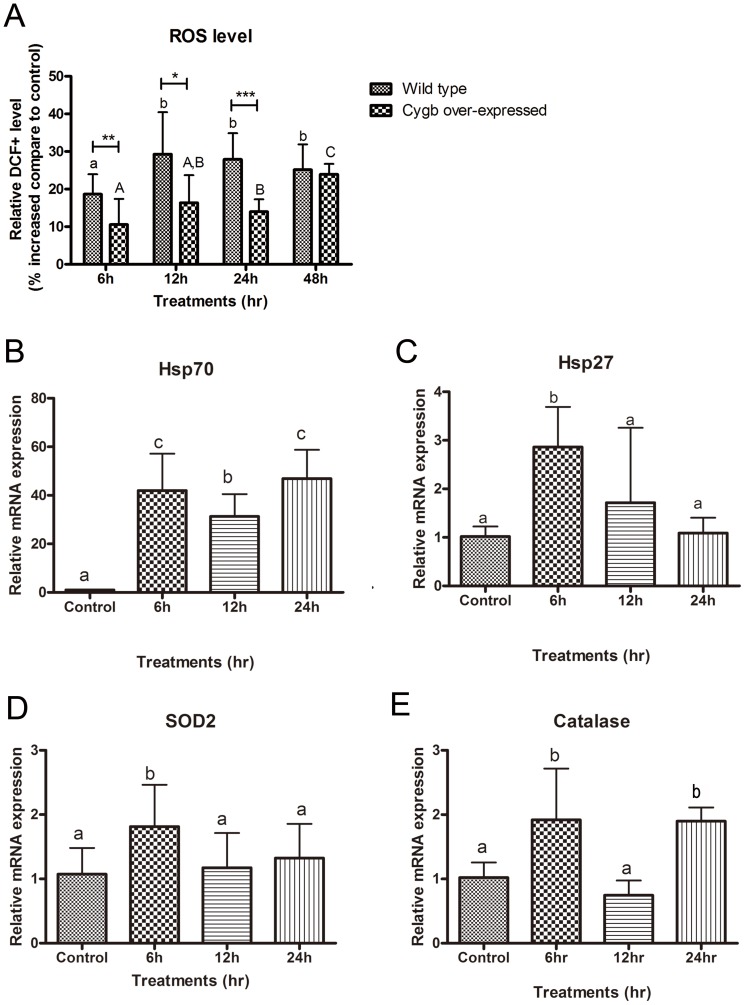
Induction of oxidative stress in BEAS-2B cells by ZEA.(A) Levels of ROS in wild type and CYGB over-expressed cells detected by DCFH-DA probe using flow cytometry. Relative DCF+ levels (equivalent to intracellular ROS levels) were expressed as percentage increased compare to DMSO control. Bars with a and b denote significant differences in wild type whereas A,B and C reflect significant differences in CYGB over-expressed cells (One-way ANOVA, p<0.05). *, ** and *** represent p<0.05, p<0.01 and p<0.001 denoting significant differences from respective wild type values. The mRNA expression of oxidative stress related genes in BEAS-2B cells were quantified by real-time PCR. The mRNA expression of β–actin was used for normalization. (B) Heat shock protein 70 (Hsp70). (C) Heat shock protein 27 (Hsp27). (D) Superoxide dismutase 2 (SOD2). (E) Catalase. Results represent the mean± SD of at least 3 independent experiments. Bars with different alphabets are significant different (One-way ANOVA, p<0.05).